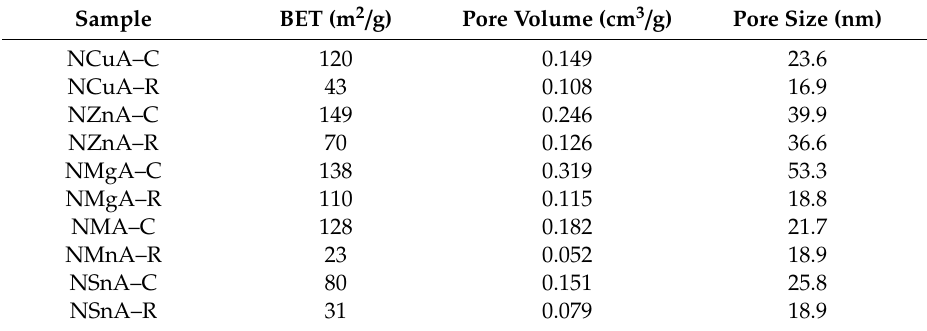
Table 1. Textural characteristics of the calcined and reduced catalysts derived from hydrotalcite.